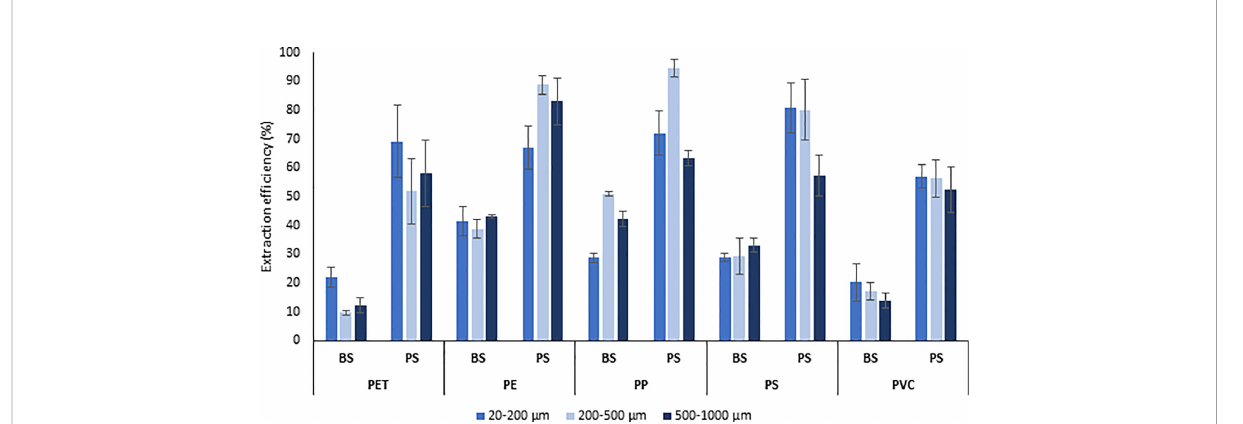
FIGURE 4 Extraction ef fi ciency (%) of different microplastic polymers and size ranges (500-1000 µm, 200-500 µm, and 20-200 µm) from deep-sea sediments comparing the two different approaches applied to bulk (BS) and partitioned (PS) sediments. PET, Polyethylene terephthalate; PE, Polyethylene; PP, polypropylene; PS, polystyrene; PVC, Polyvinyl